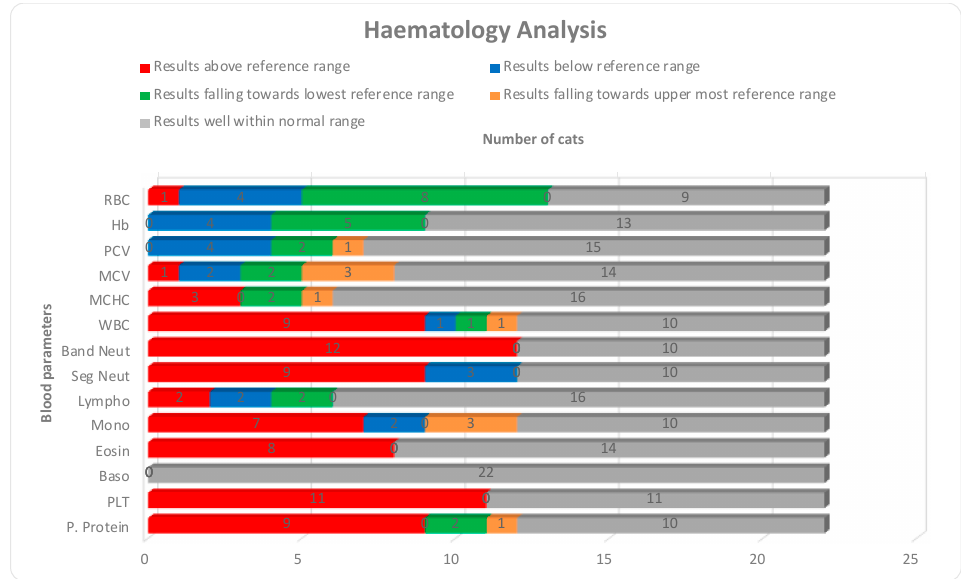
Figure 1. Comparison of changes in hematology parameters in a total of 22 cats with reference to their reference range.